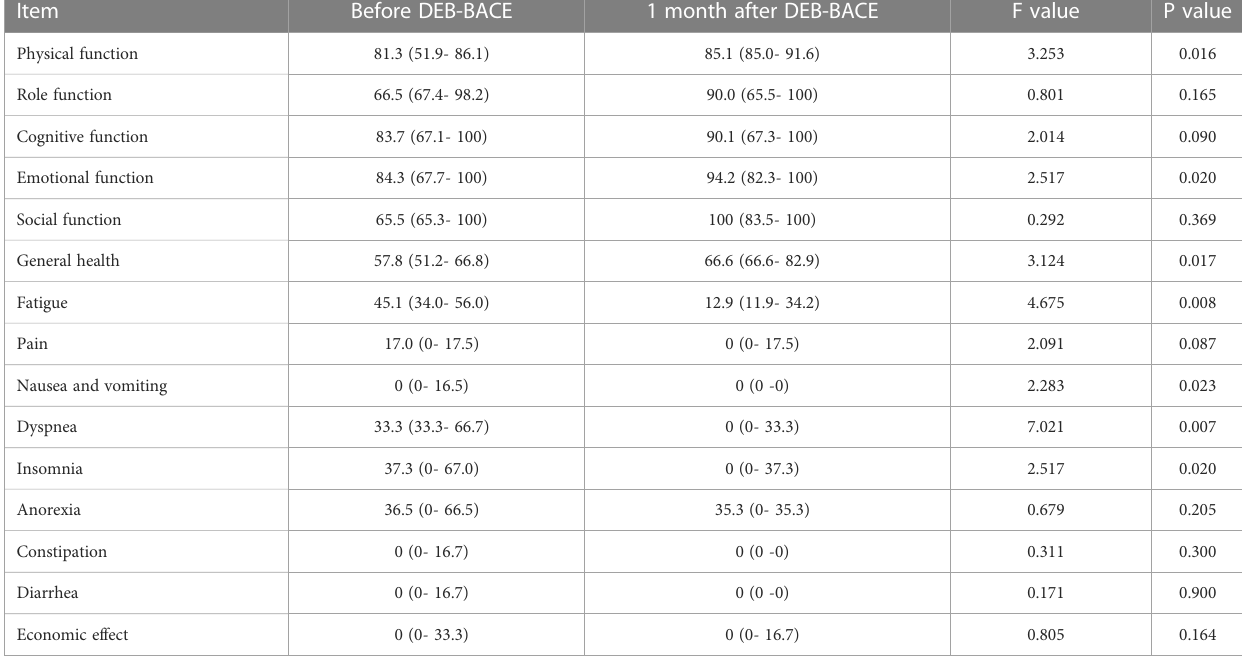
TABLE 3 Quality of life score [M(QL-QU)] of 43 patients before and after